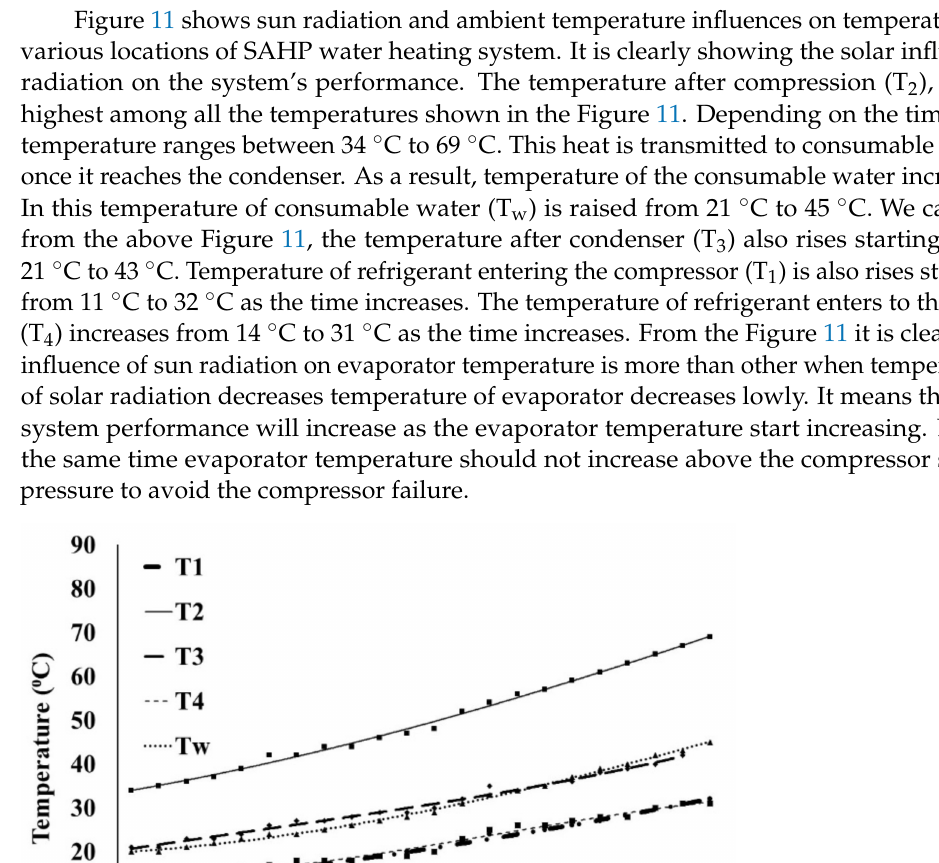
Figure 10. Variation of Solar Radiation with time on 6 April 2022 (summer).